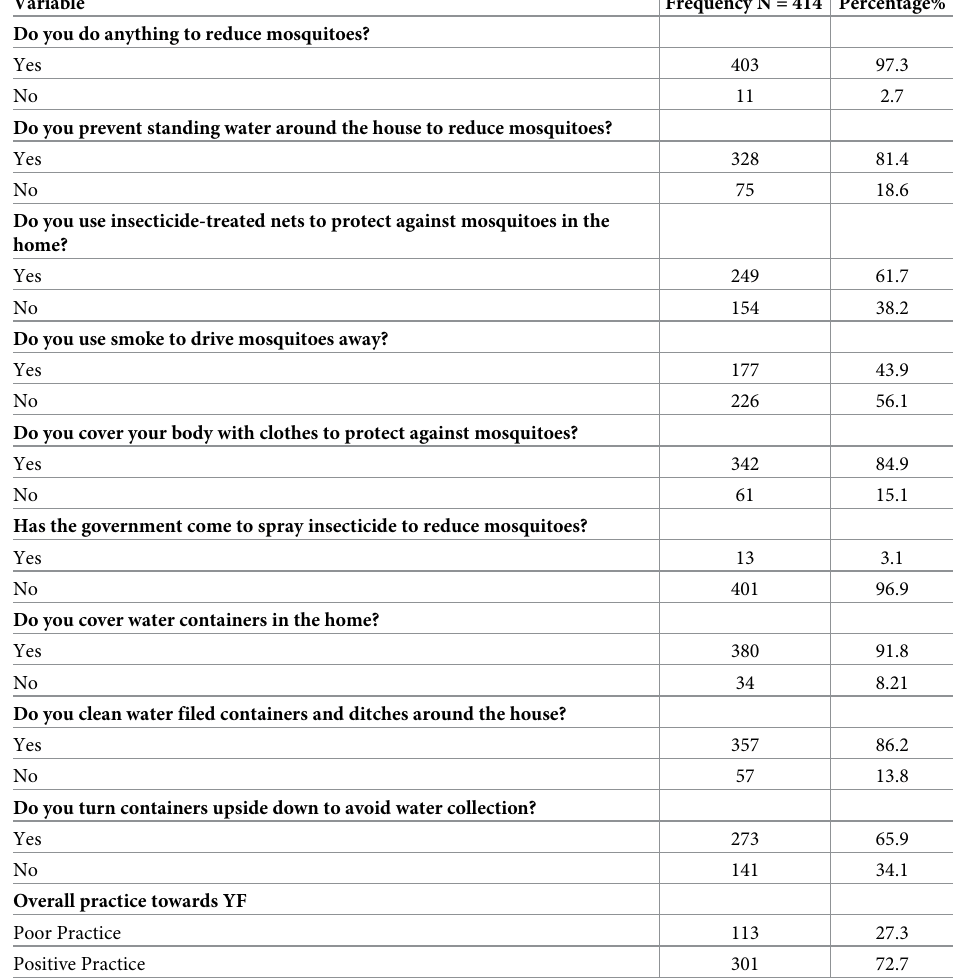
Table 5. Nomadic practices toward yellow fever in yellow fever outbreak communities in the West Gonja Munici- pal, Ghana, 2022.